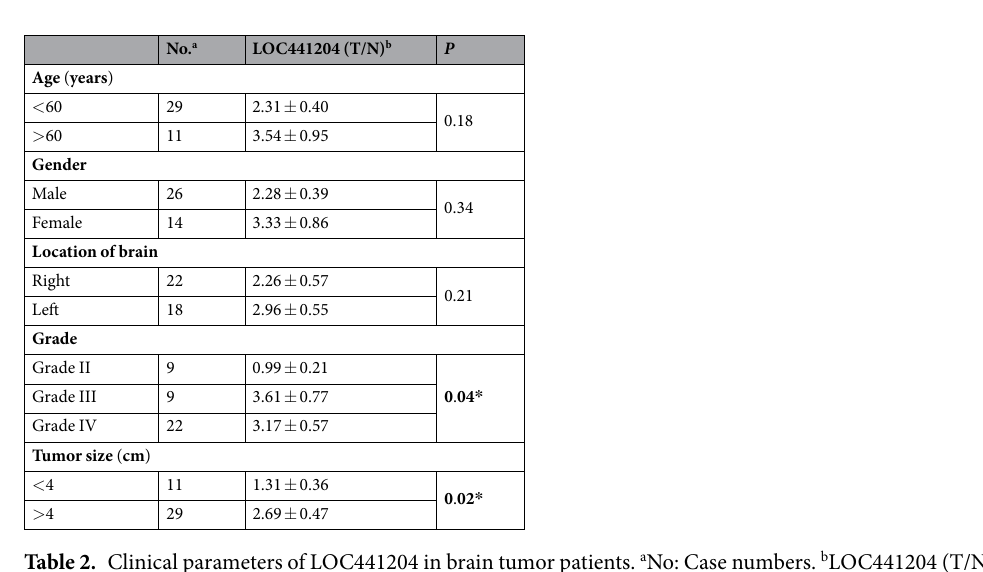
Table 2. Clinical parameters of LOC441204 in brain tumor patients. a No: Case numbers. b LOC441204 (T/N): Fold change of LOC441204 expression in clinical